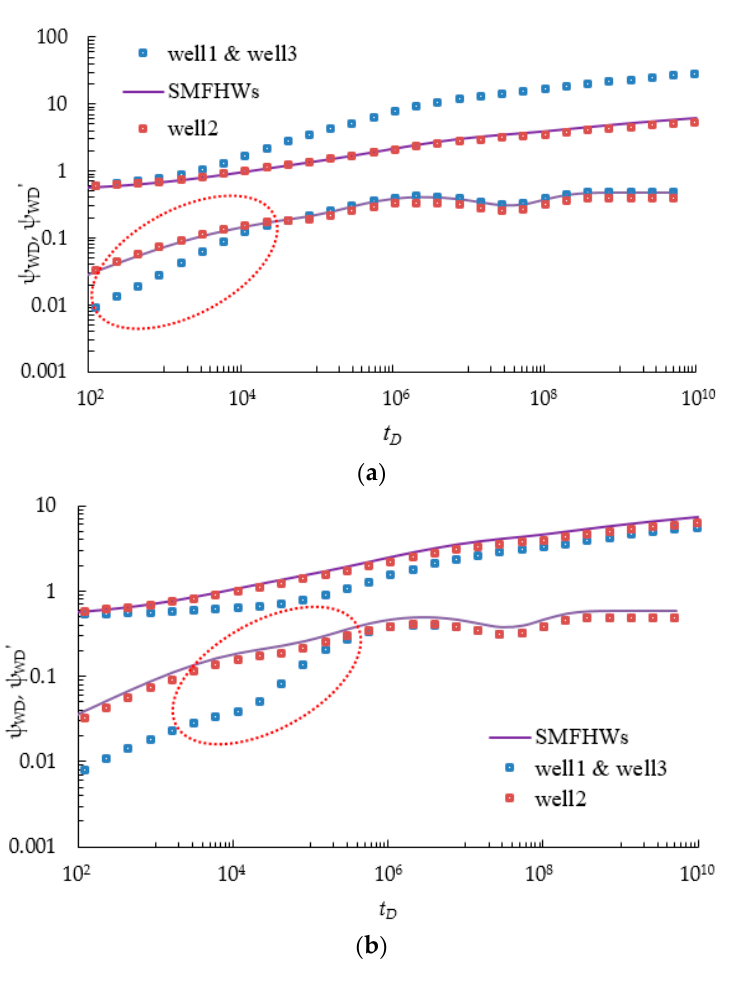
Figure 11. Comparison between SMFHWs and MWPs scheme ( q 1 : q 2 : q 3 = 1:2:1): ( a ) Figure 2b, Case 1; ( b ) Figure 2b, Case